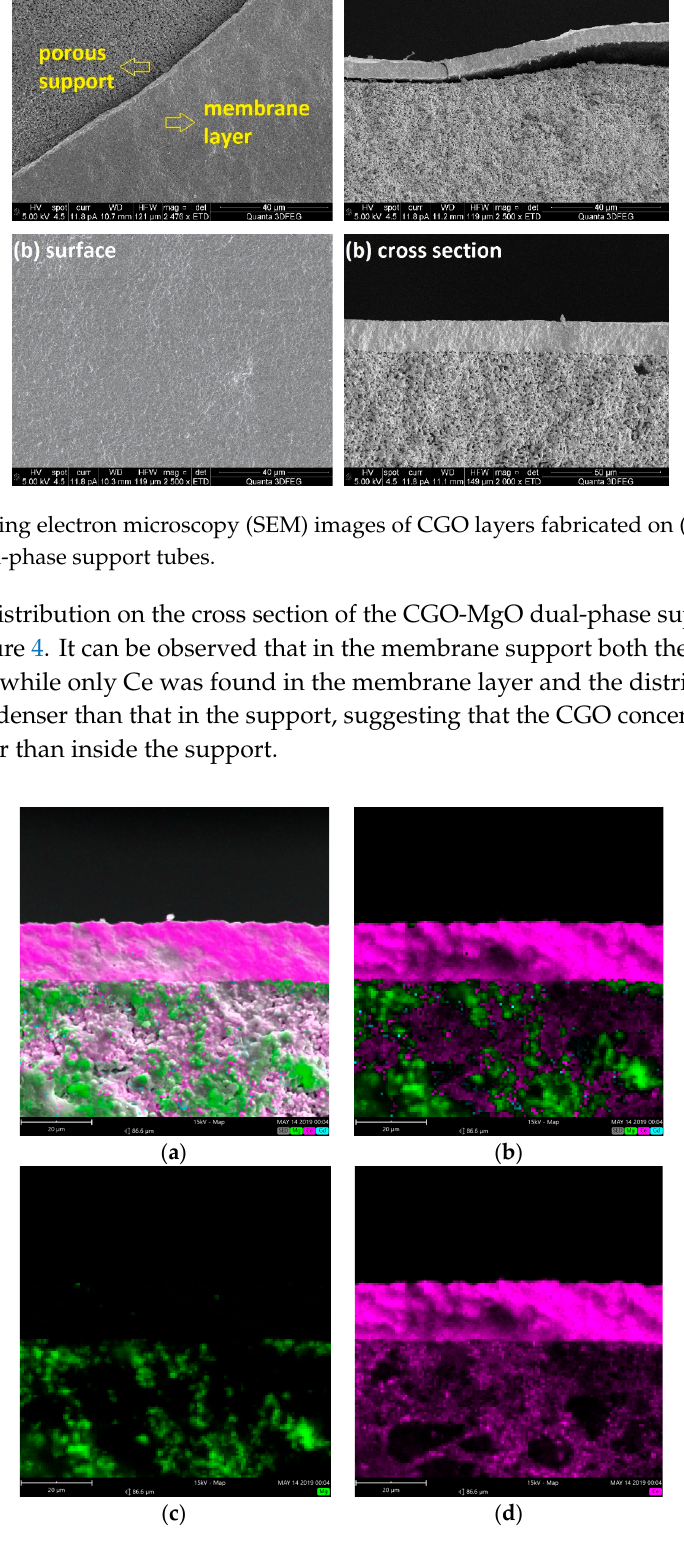
Figure 4. Element distribution on the cross section of the CGO-MgO dual-phase supported membrane: ( a ) Combined mapping and SEM image; ( b ) Combined element mapping; ( c ) Mg mapping; ( d ) Ce